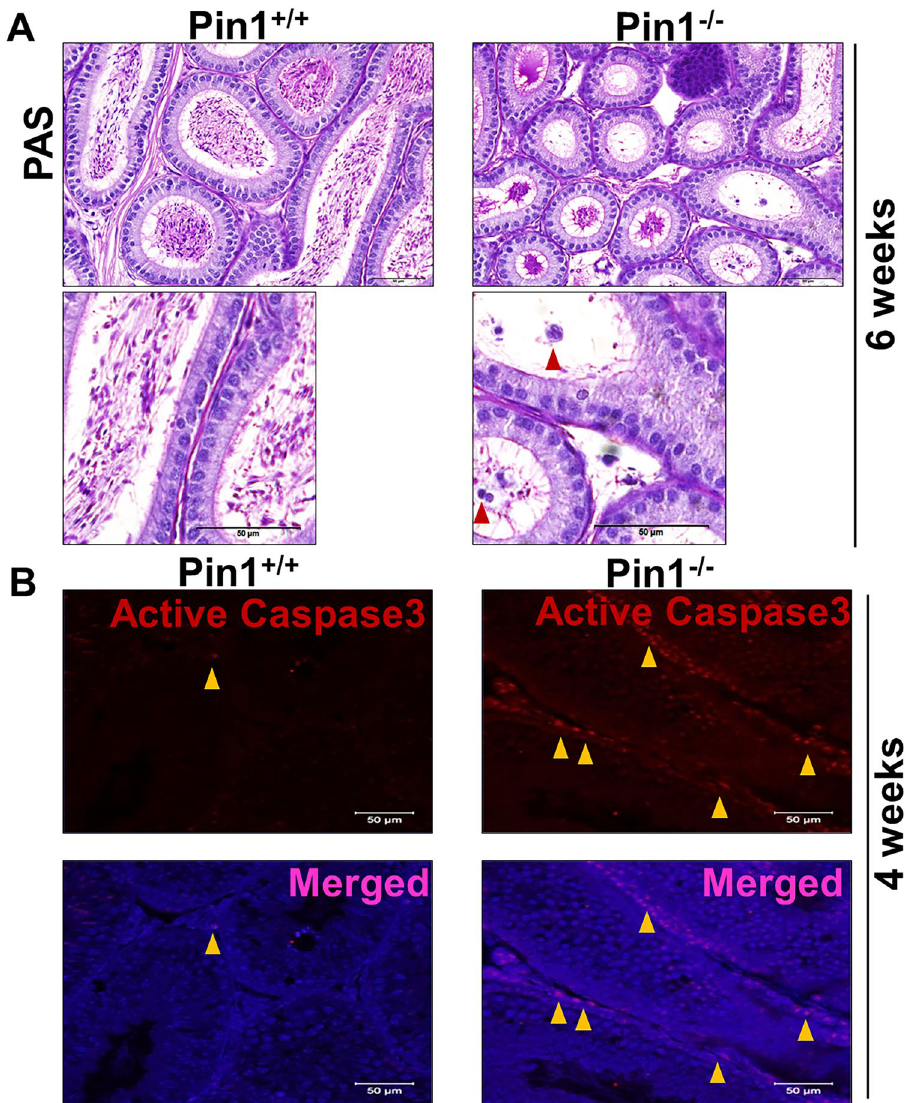
Figure 3. Pin1 − / − testis shows signs of compromised immune privilege. ( A ) Epididymides of 6-week-old mice were fixed and sectioned to observe any abnormalities. Red arrows indicate blood cells or abnormal germ cells (scale bar = 50 µ M). ( B ) Testis sections were stained with antibody against active caspase 3 (BD Bioscience) to evaluate apoptosis (scale bar = 50 µ M). Yellow arrows indicate cells with nuclei immunostained for active- caspase 3